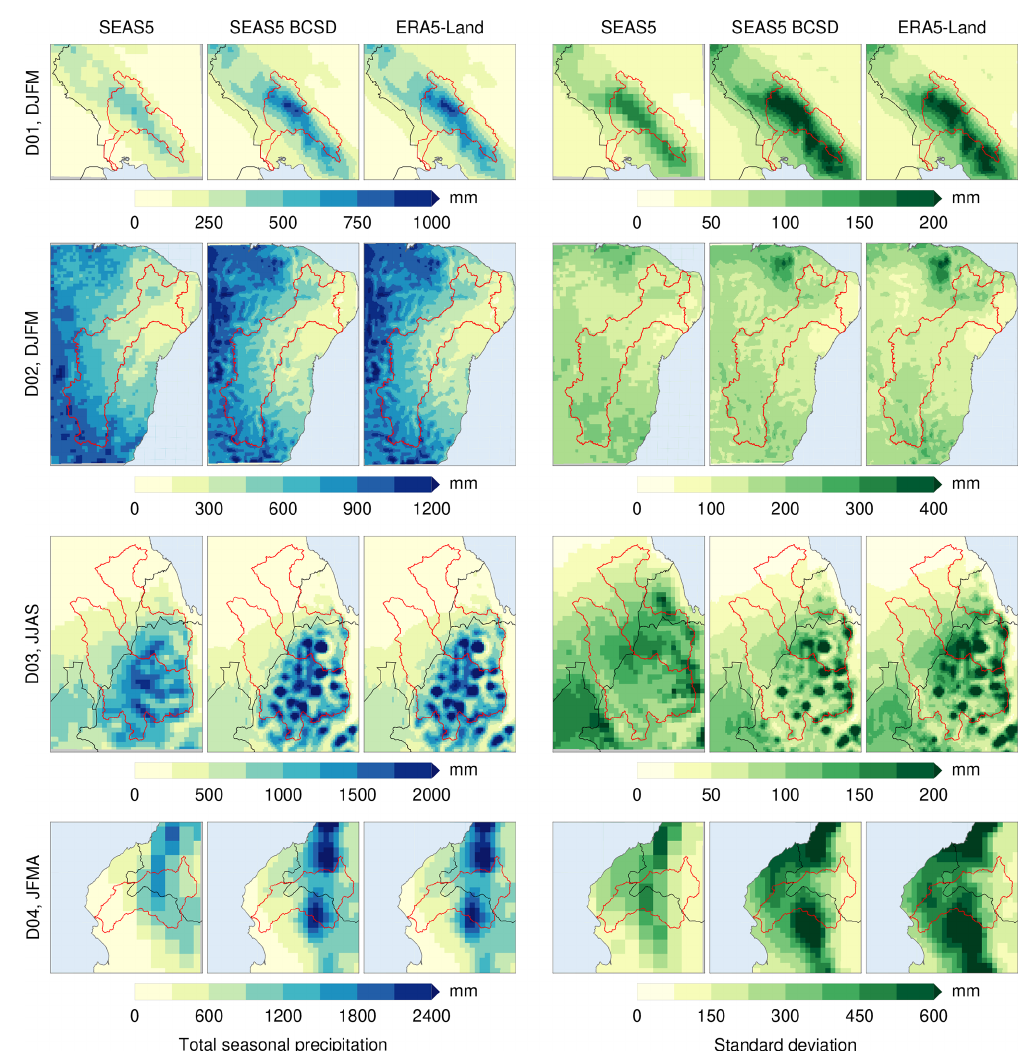
Figure 4. Total precipitation (left three columns) and the corresponding standard deviation (right three columns) during the 4 main months of the rainy season for the four study domains from raw SEAS5 and SEAS5 BCSD lead-0 forecasts and ERA5-Land, averaged over the period 1981 to